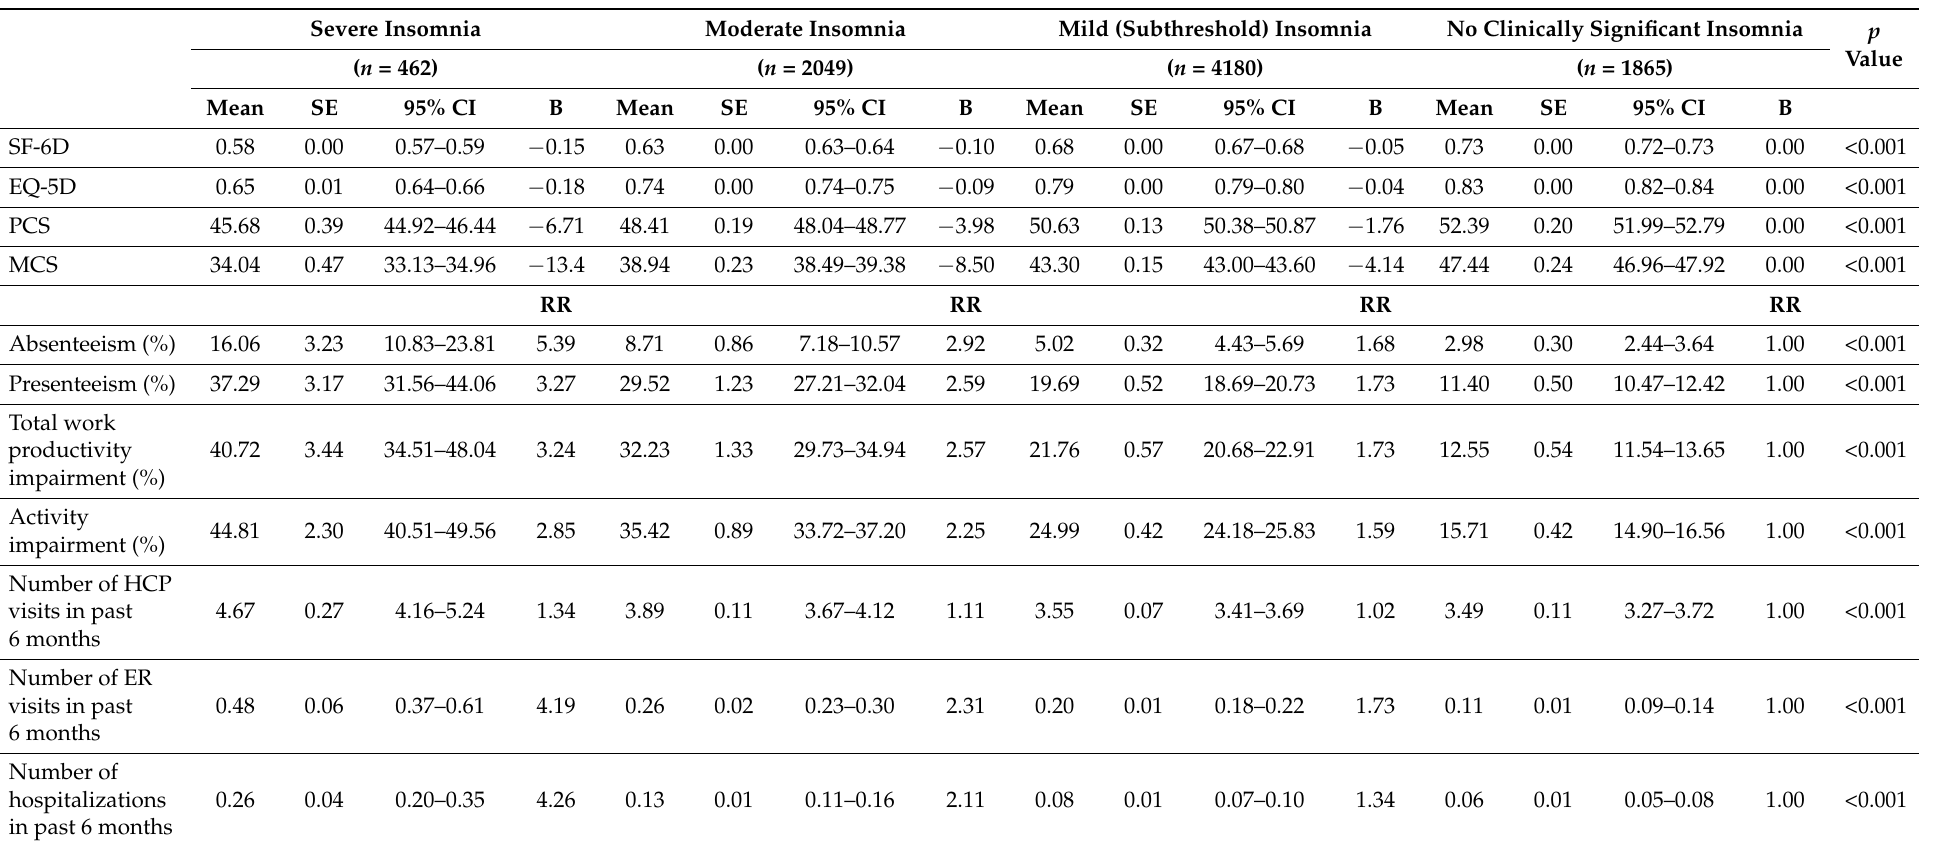
Table 3. Adjusted results showing association between outcomes by ISI severity group. Covariates adjusted for: age, sex, marital status, education, employment status, smoking status, alcohol use, body mass index, total days experienced insomnia in last 12 months, any psychological comorbidities (depression, post-traumatic stress disorder, all anxiety), all pain,